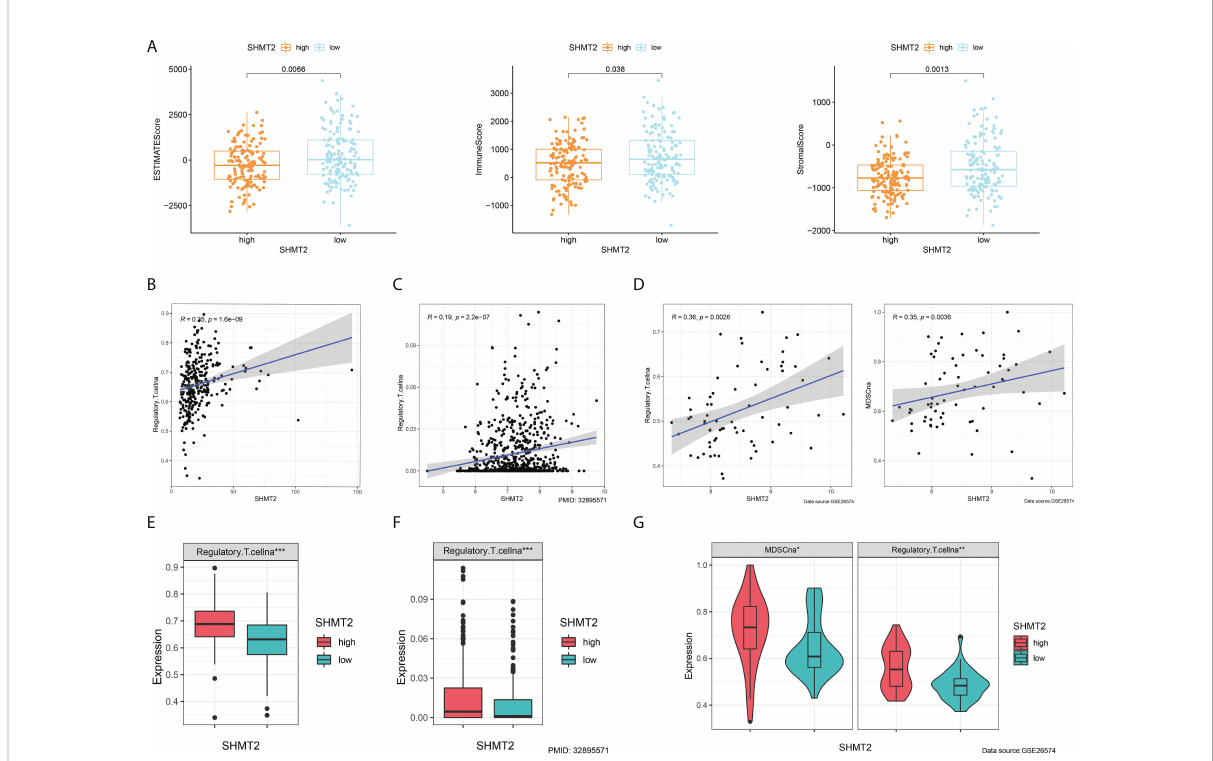
FIGURE 5 SHMT2 was associated with the immunosuppressive microenvironment of pRCC. (A) Correlation analyses of SHMT2 expression with tumour- in fi ltrating immune cells (TICs) from the ESTIMATE algorithm. High SHMT2 expression was associated with low ImmuneScores (p = 0.038), StromalScores (p = 0.0066), and ESTIMATEScores (p = 0.0013). (B – D) Correlation analyses of SHMT2 expression with the proportion of primary immunosuppressive cells in (B) TCGA samples, (C) NIHMS1737783 samples, and (D) GSE26574 samples. (E, F) High SHMT2 expression corresponded with signi fi cantly higher Treg cell in fi ltration in (E) TCGA samples, (F) NIHMS1737783 samples, and (G) GSE26574 samples. In addition, MDSCs were more easily enriched in the high – SHMT2 expression subgroup; *p < 0.05, **p < 0.01, and ***p <